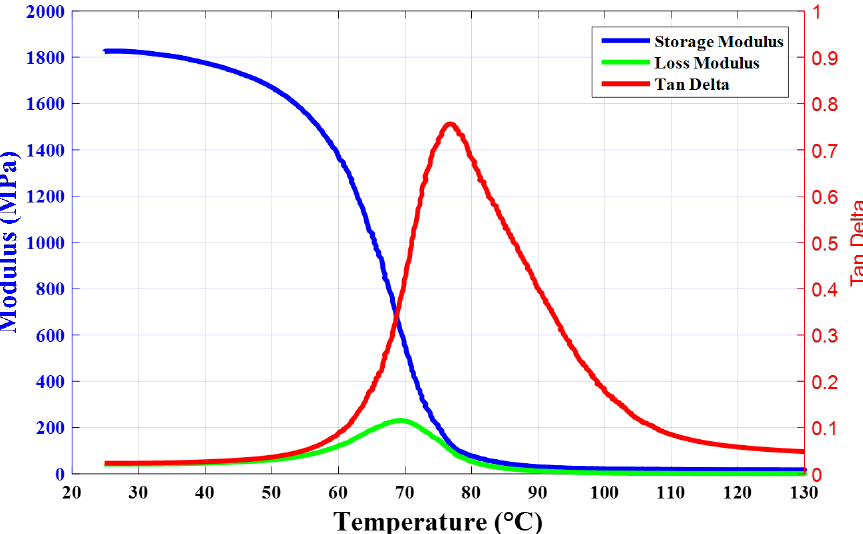
Figure 4. Dynamic thermal mechanical analysis for MWNTs / epoxy resin